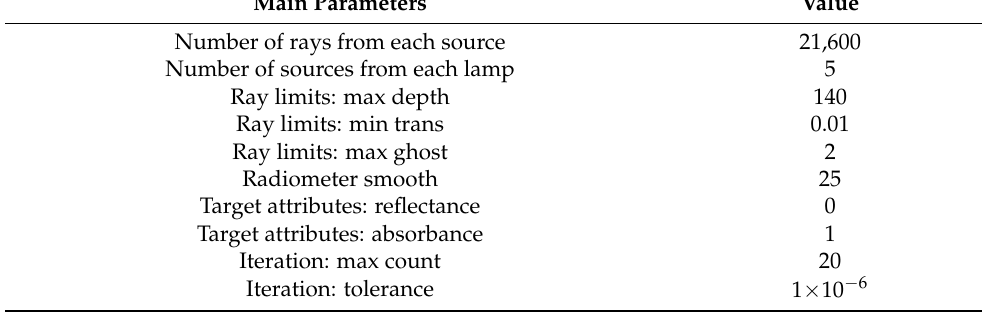
Table 2. Main parameters of Opticad simulations.